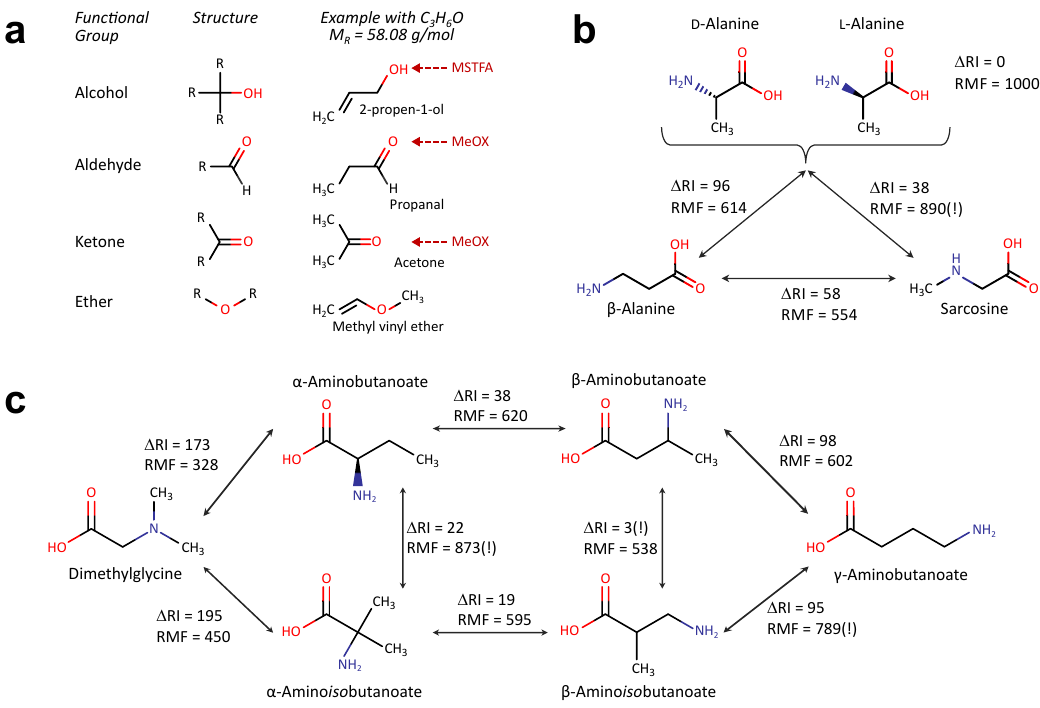
Figure 2. Discrimination of different functional groups by derivatisation. ( a ) Scheme illustrating the accessibility of different functional groups towards silylation (MSTFA) and methoxymation (MeOX). ( b , c ) Pairwise comparison of retention indices (RI) and reverse match factor (RMF) for metabolites with sum formula C 3 H 7 NO 2 (detected as 2-TMS product) ( b ) and metabolites with sum formula C 4 H 9 NO 2 ( c ). Δ RI: difference in retention index, stored in the GMD for metabolites with comparable derivatisation states (similar RI window), RMF: similarity of mass spectra obtained in pairwise comparison (0: no similarity—1000: